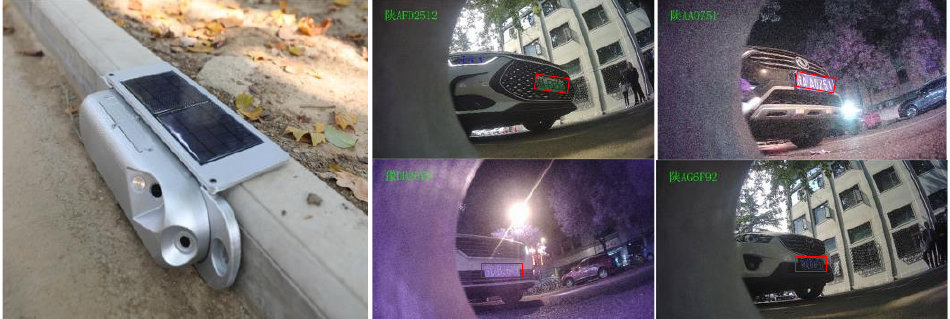
Table 7. Comparative experimental results of license plate detection and character recognition.